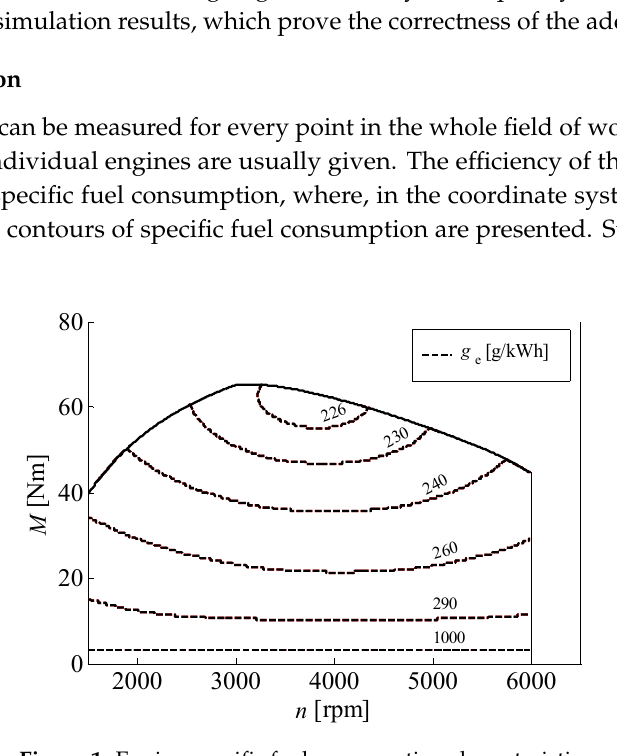
Figure 1. Engine specific fuel consumption characteristic.